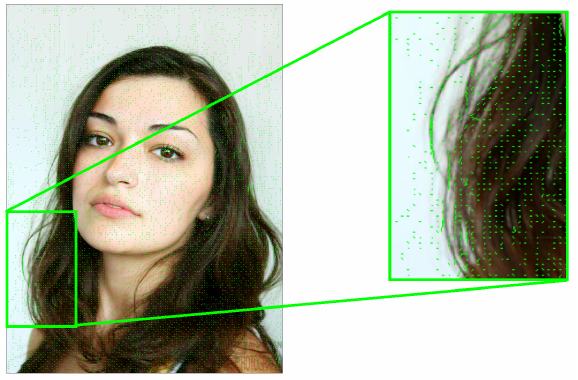
Figure 5. The vector field of the image corresponding to vector ν 2 , the length of vectors is proportional to | λ 1 | .